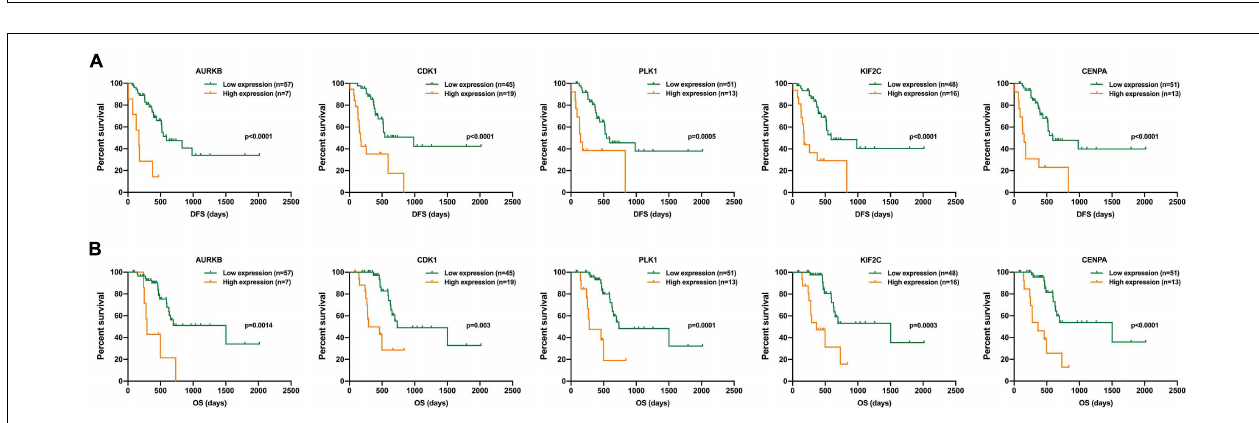
FIGURE 7 | PPI network and functional analysis of three hub modules. (A,B) Brown module. (C,D) Turquoise module. (E,F) Purple module.